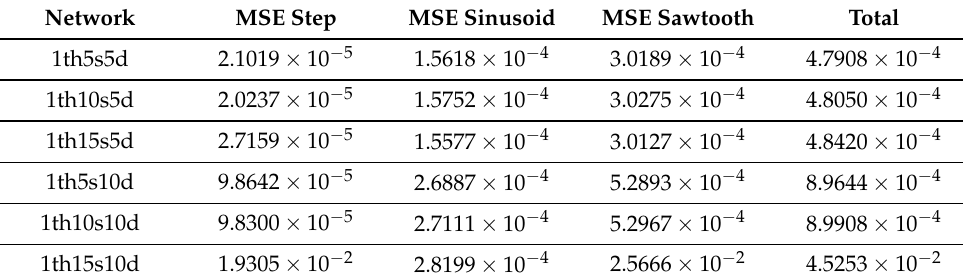
Table 8. MSE obtained by the inverse model control networks for the different reference signals.